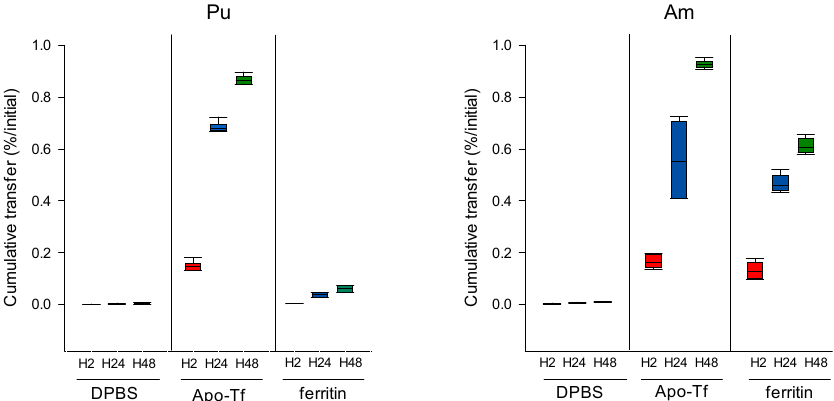
Figure 4. Pu/Am transfer in the presence of proteins in the dynamic phase. Pu or Am were included in the static phase prepared in DPBS. After 2, 24, and 48 h incubation in DPBS supplemented with ApoTf (50 µM) or ferritin (10 µM), the transferred activity was measured in the dynamic phase using liquid scintillation counting. Results are expressed as cumulative activity/initial activity in the gel. Each experimental condition was done in triplicate and repeated twice. Table 2. Pu/Am transfer enhancement in the presence of proteins or DTPA in the dynamic phase. Ratio of medians of transferred activity in dynamic phase supplemented with ligands vs. control (DPBS alone) and median of cumulative transfer (%). Results are from two experiments performed in triplicate.